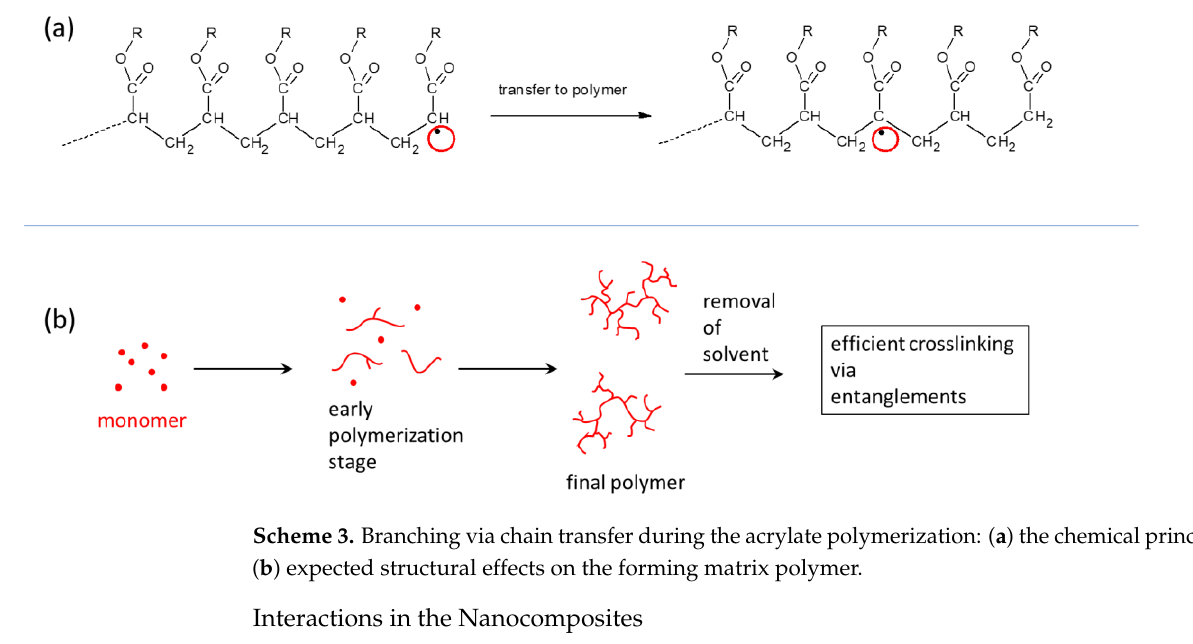
6 of 33 Figure 1. Appearance of selected samples of polyMEA-based materials in dry state (left) and after 1 month of swelling in water bath. 2.1.2. Structure of Crosslinking in the Nanocomposites In Scheme 2, the basic structural features of the prepared nanocomposite elastomeric networks are shown (they were studied in detail in previous work [52,53]): Polymer chains anchored by adsorption on clay platelets (Scheme 2a) are the most basic feature, which also is the basis of the distantly related ultra-extensible and tough poly(N-isopropy- lacrylamide) (PNIPAm)/clay hydrogels, mentioned in the Introduction. The very efficient adsorption of a long chain segment is the result of the previous adsorption of